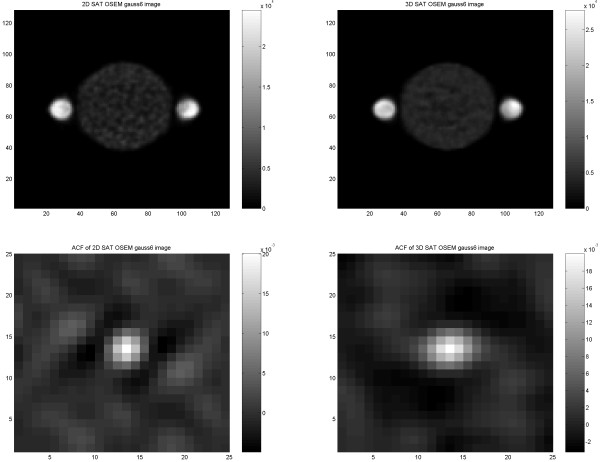
Results of the satellite phantom study (NEMA phantom with adjacent hot cylinders). 2D image (upper left) and 3D image (upper right) reconstructed using OSEM with applied 6 mm (FWHM) Gaussian filter. Corresponding ACF images of 2D (lower left) and 3D image (lower right).